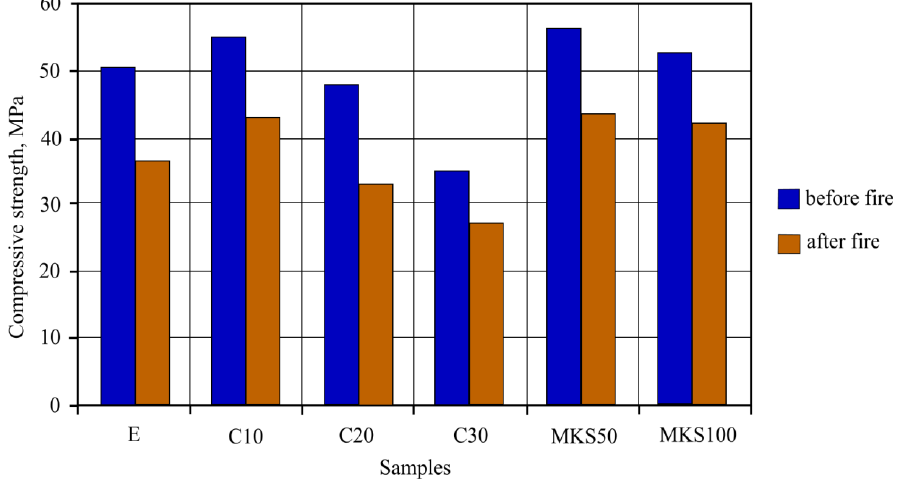
Figure 13. Sample compressive strength before and after fire effect results.